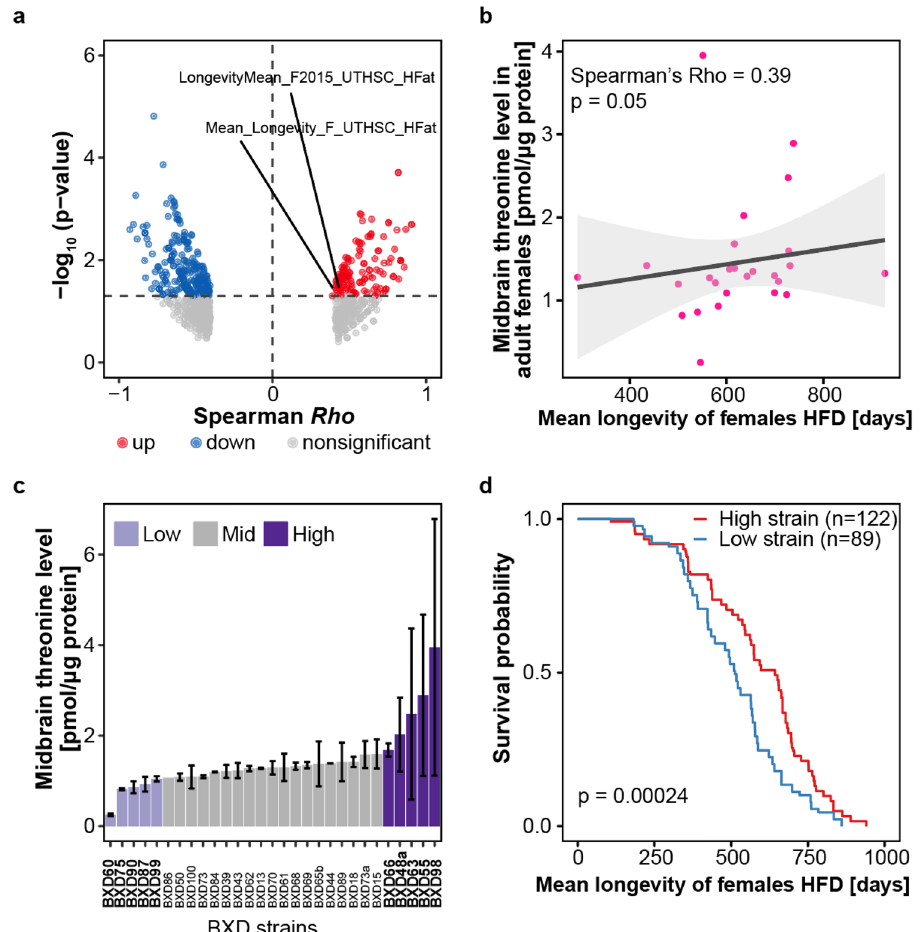
Fig. 5 | The relation of midbrain threonine concentration of male mice with their lifespan. a The midbrain threonine levels in male adult male mice with life- span under control diet (CD) or high fat diet (HFD) condition. b The correlation of midbrain threonine level in adult males with mean lifespan of HFD mice ( P